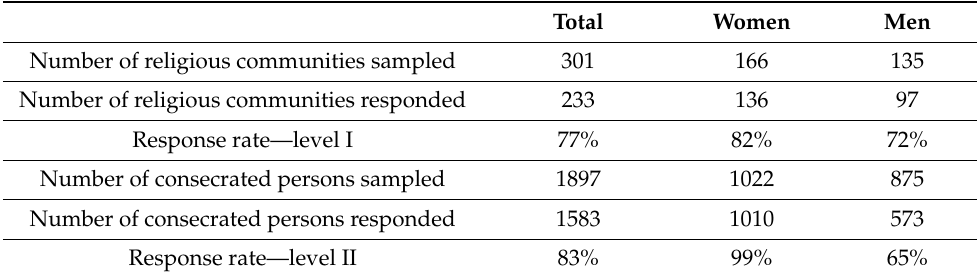
Table 2. Survey response rate.